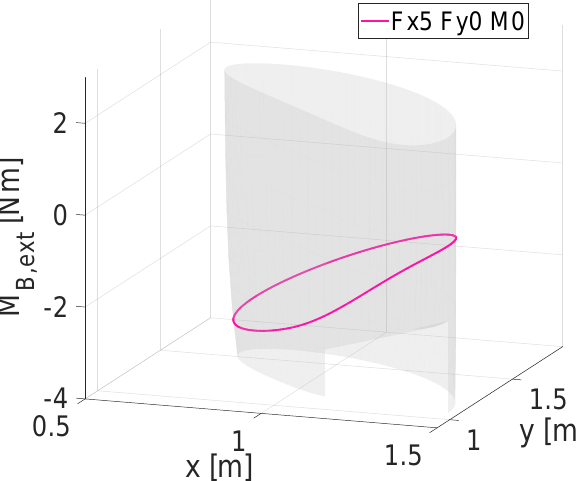
Figure 16. Trajectory for an external applied load of 5 N in the positive